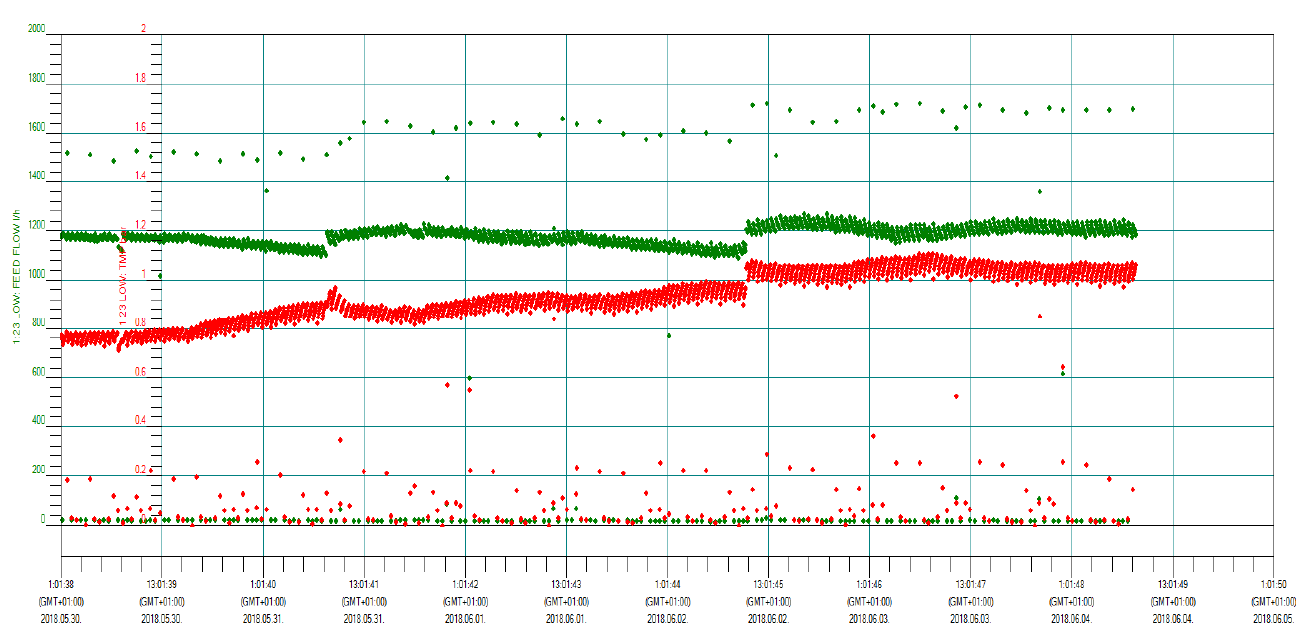
Figure A10. Flow and TMP—the impact of bentonite dosing.